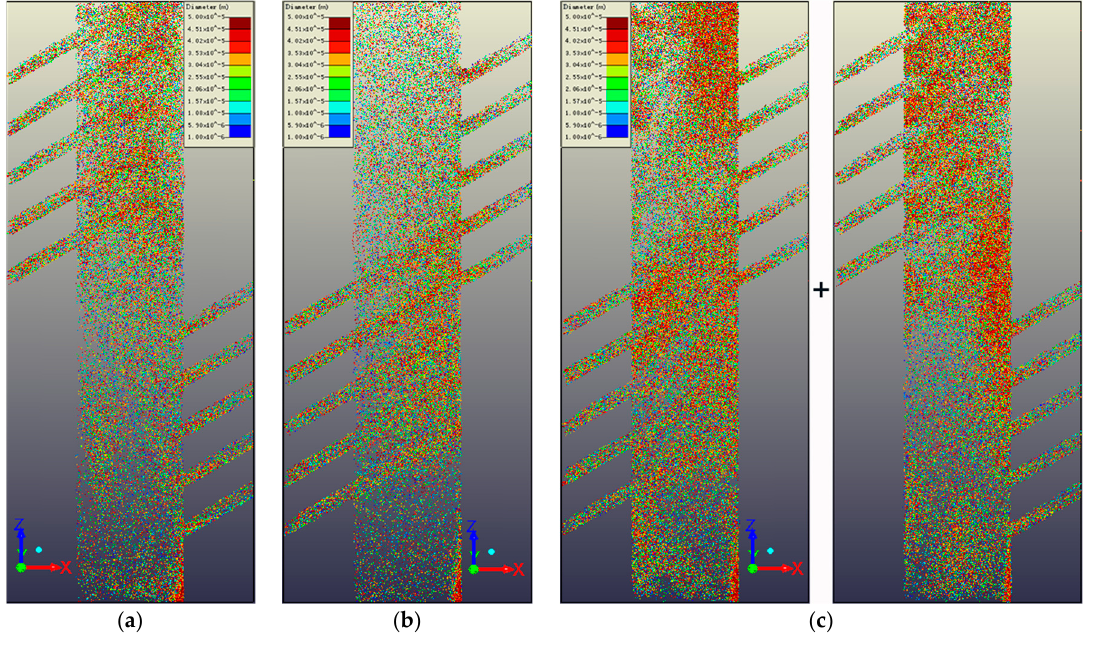
Figure 10. Distribution of the inclusions in the MHDB. ( a ) UILO mode; ( b ) LIUO mode; ( c ) X mode.